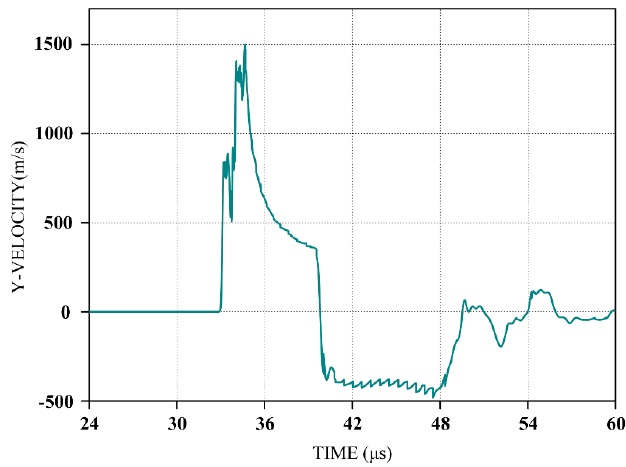
Figure 13. Y-velocity–time curve at gauge point 12.